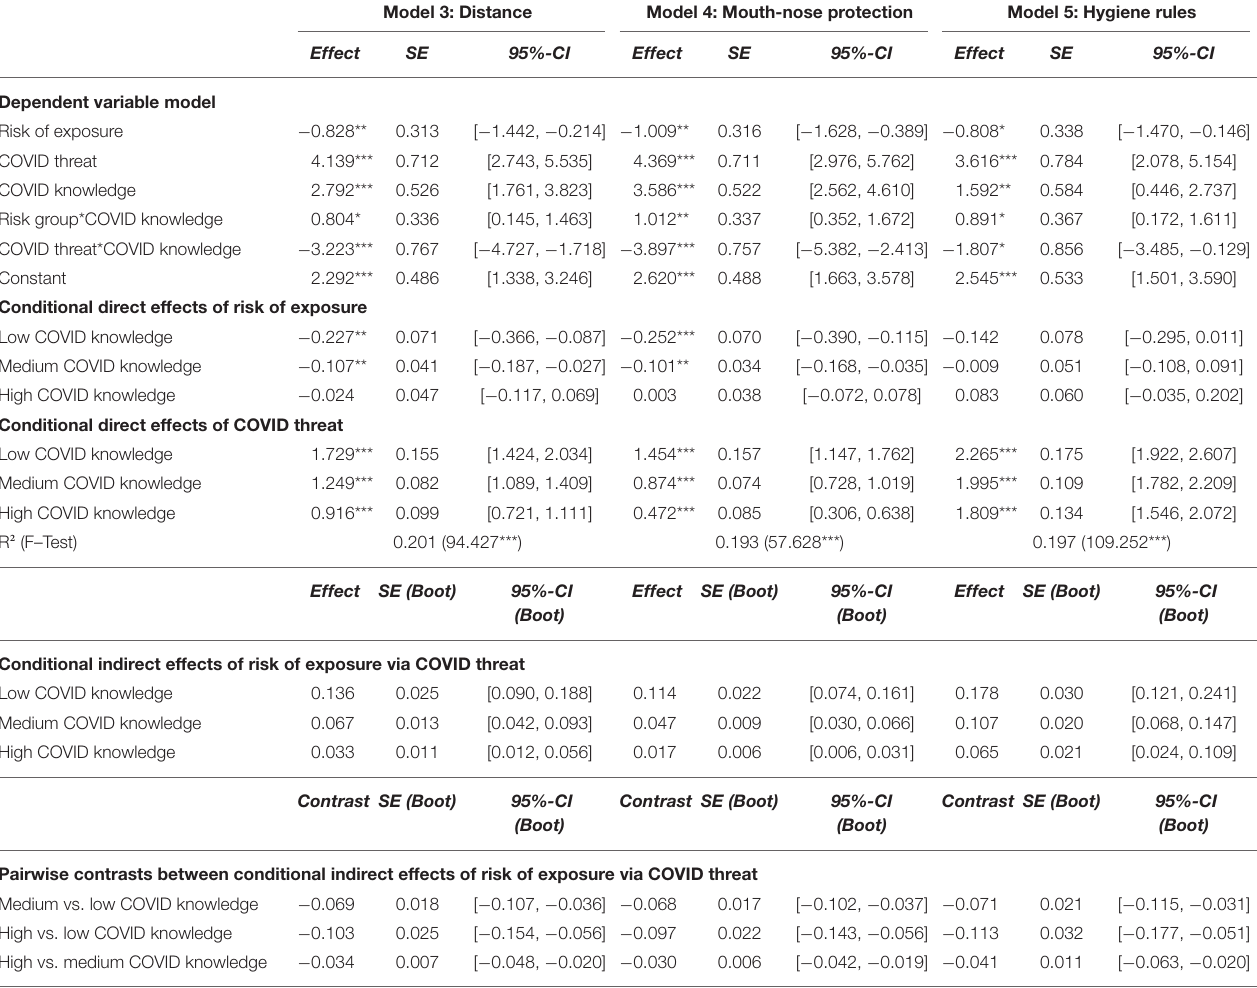
TABLE 4 | Dependent variable model of the conditional mediation model ( N = 4,096) a